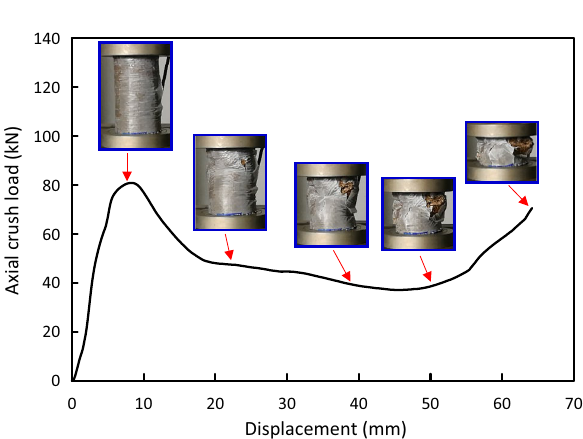
Figure 5. Load–displacement and crushing history for Al test specimen.